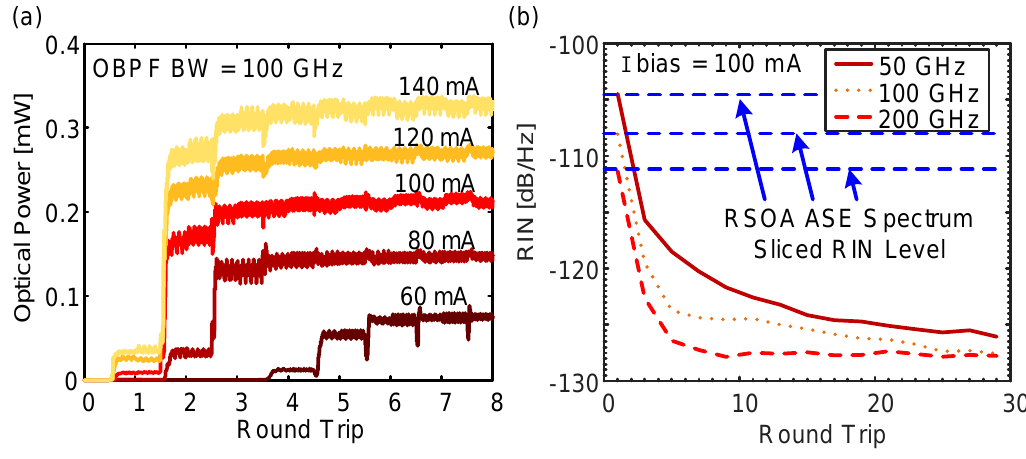
Figure 7. Evolution of ( a ) output power and ( b ) RIN with the number of cavity round trips. The output power builds up within the first few round trips before saturating. The RIN also follows a similar evolution in time before it reaches its minimum